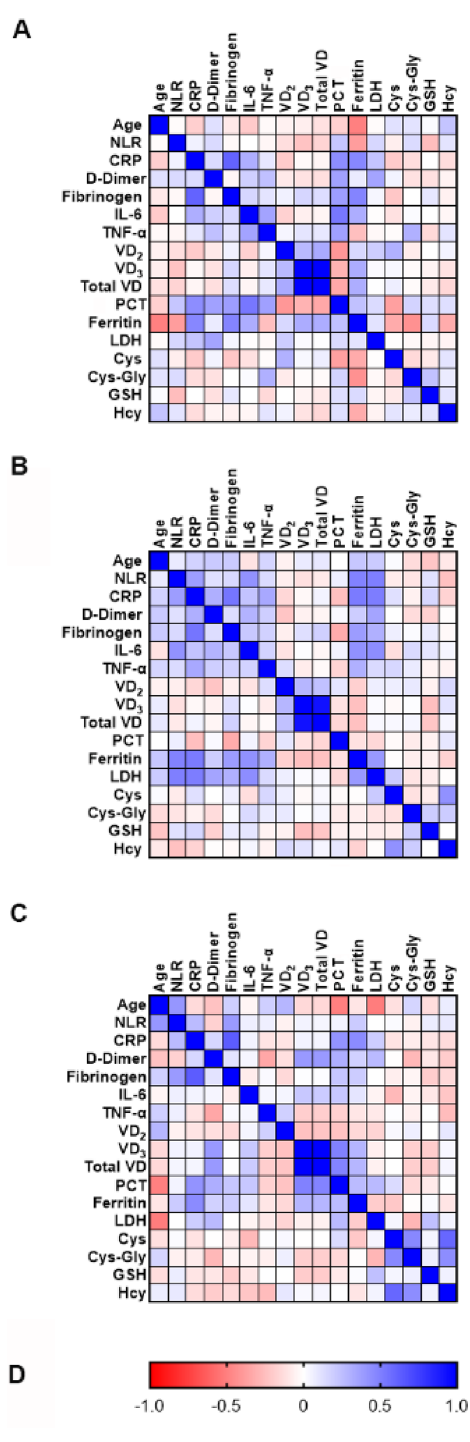
Figure 2. Spearman’s correlation analysis of the measured clinical variables. The figure shows the heatmaps of the correlation between all the parameter studied in the adult non-survivors (NS, panel A ), in the adult survivors (S, panel B ), and in children (C, panel C ). Spearman’s correlation coefficients vary according to the color scale shown in the panel ( D